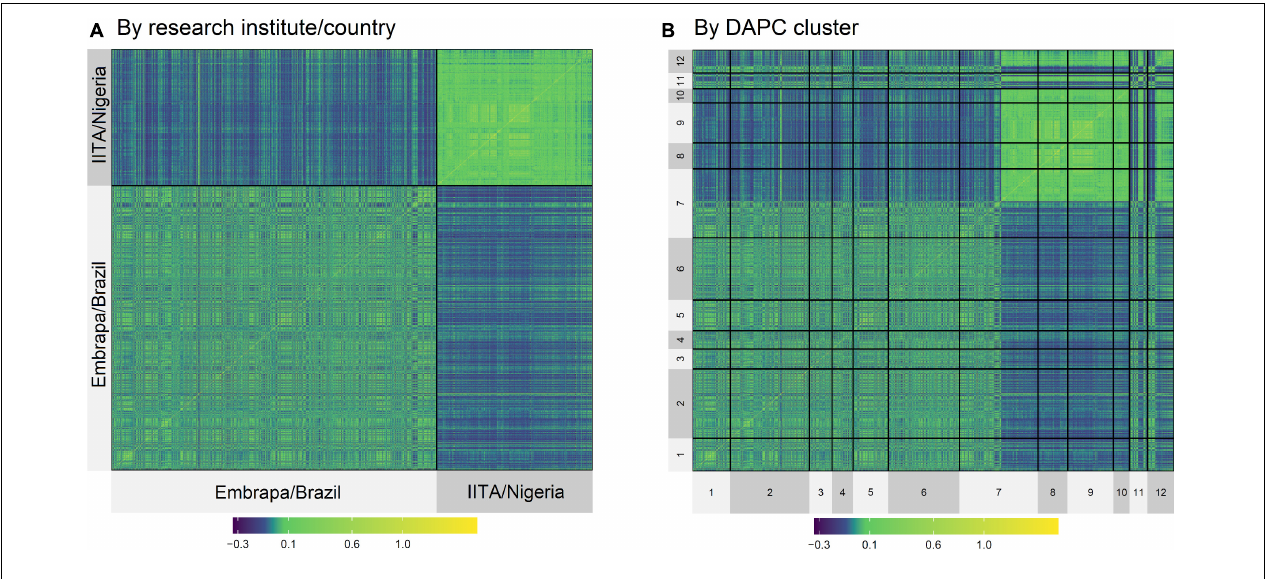
FIGURE 2 | Heatmap of the kinship G matrix by Institute/Country (A,B) by DAPC Cluster (1–12).